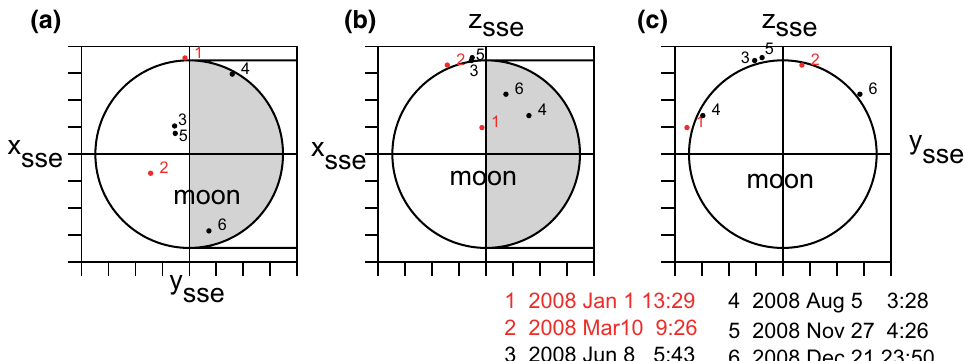
Fig. 10 Distribution of short-period magnetic enhancements detected by Kaguya. Position of Kaguya at the detection of short-period magnetic enhancements projected on the a x − y , x − z , and y − z planes of the SSE coordinate system. Red dots (#1 and #2) are limb compressions found in the constant solar wind magnetic field, and black dots are those found at interplanetary magnetic discontinuities. Event numbers are the same as those in Table